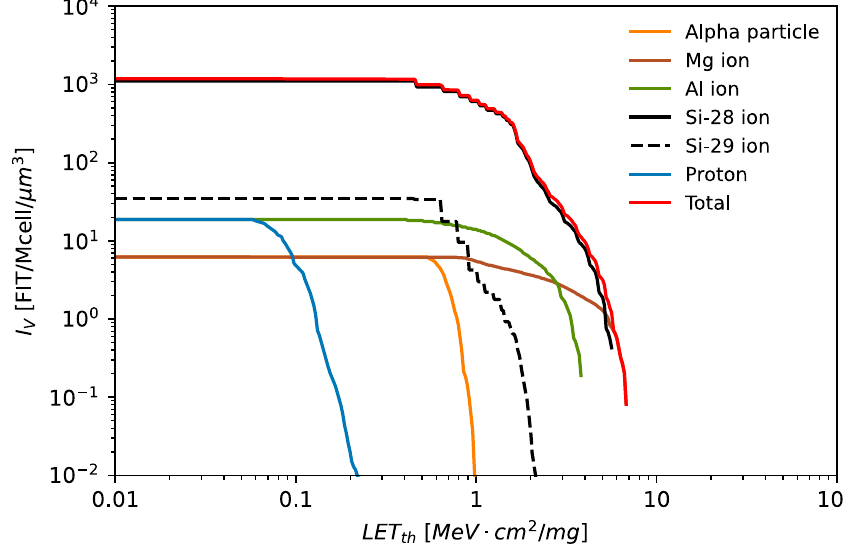
Figure 6. I V function as a function of LET threshold for atmospheric neutrons in the 1–10 MeV energy range.